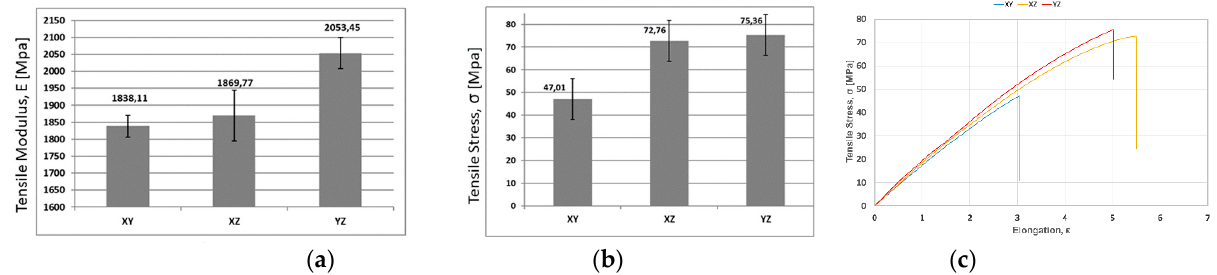
Figure 7 . Experimentally measured mechanical properties: ( a ) tensile modulus, E; ( b ) tensile stress, σ ; ( c ) stress–strain averaged curves XY, XZ, YZ.